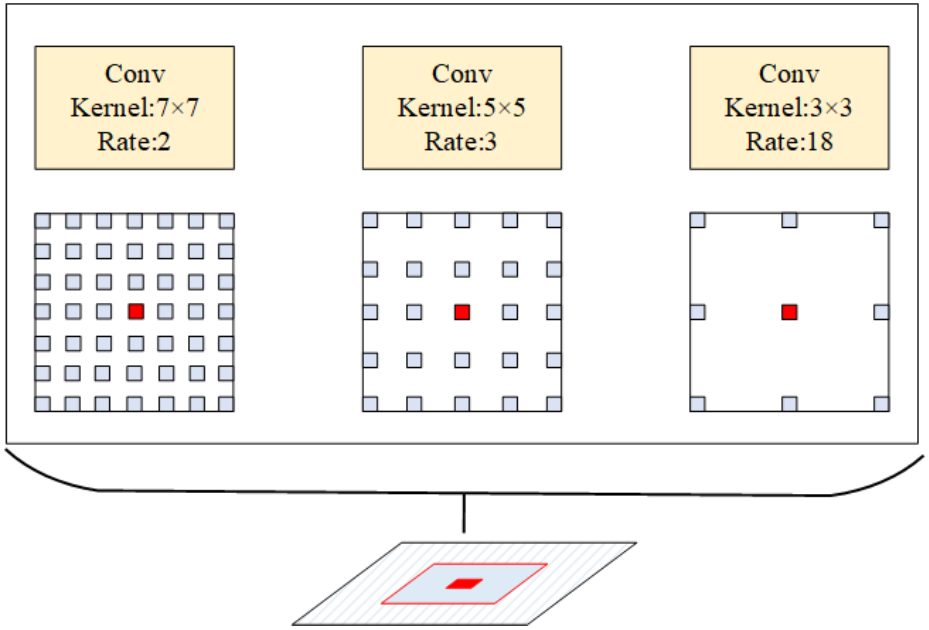
Figure 3. Schematic diagram of the atrous heterokernel convolution kernel. It extracts features under different spaces of the image in the same sensory